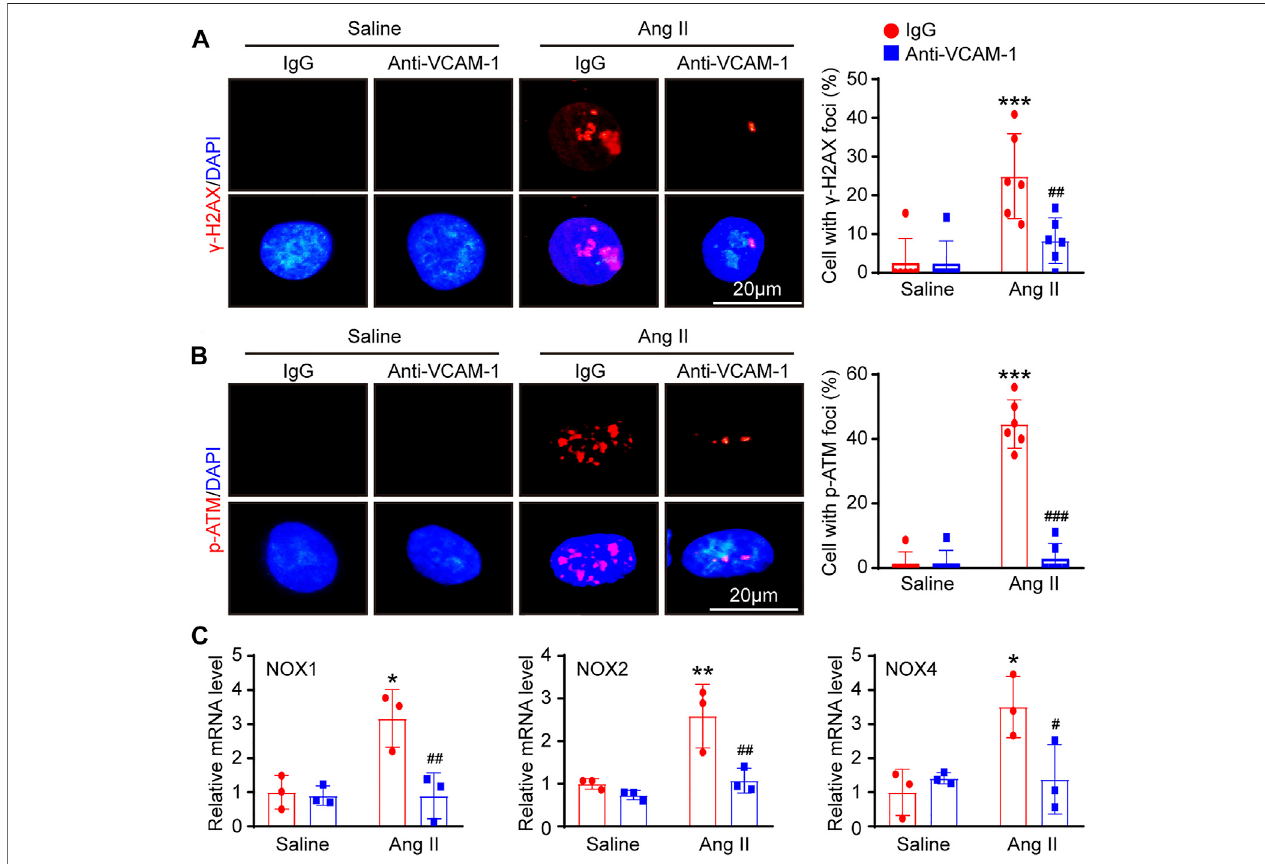
FIGURE6| InhibitionofVCAM-1alleviatesoxidative stressinHUVECs invitro . (A) Macrophages werepretreatedwithanti-VCAM-1 (5 μ g/ml)or IgGcontrolfor4 h and then stimulated withsaline or Ang II(100 nM)for an additional 24 h. Theconditioned supernatantwasadded toHUVECs. Immuno fl uorescence stainingofHUVECs with a γ -H2AX antibody (left, scale bar = 20 μ m) and quanti fi cation of γ -H2AX-positive foci (right, n = 6). (B) Immuno fl uorescence staining of HUVECs with a p -ATM antibody(left, scale bar =20 μ m) and quanti fi cation of p -ATM-positivefoci(right, n =6). (C) qPCR analysisoftheNOX1, NOX2 and NOX4 mRNAlevels in HUVECs ( n =3).Thedataareexpressedasthemean±SD,and n representsthenumberofsamples.* p < 0.05,** p < 0.01and*** p < 0.001versussaline; # p < 0.05, ## p < 0.01and ### p < 0.001 versus Ang II + IgG.